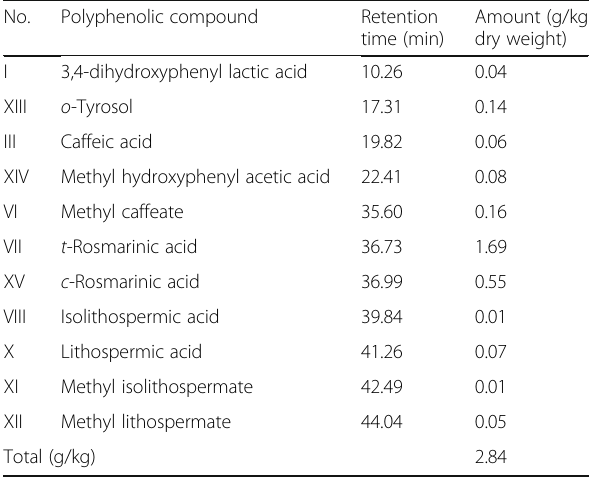
Table 5 Amount of polyphenolic compounds identified in the dichloromethane extract of Melissa officinalis leaves No.